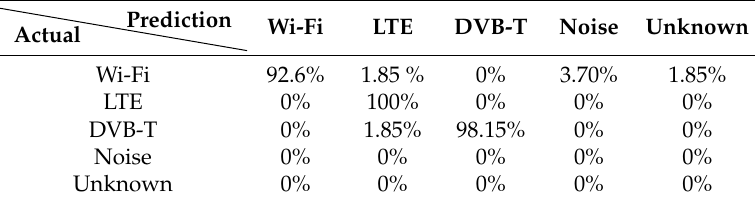
Table 2. Confusion matrix of the measurement results, for N = 20, T = 1